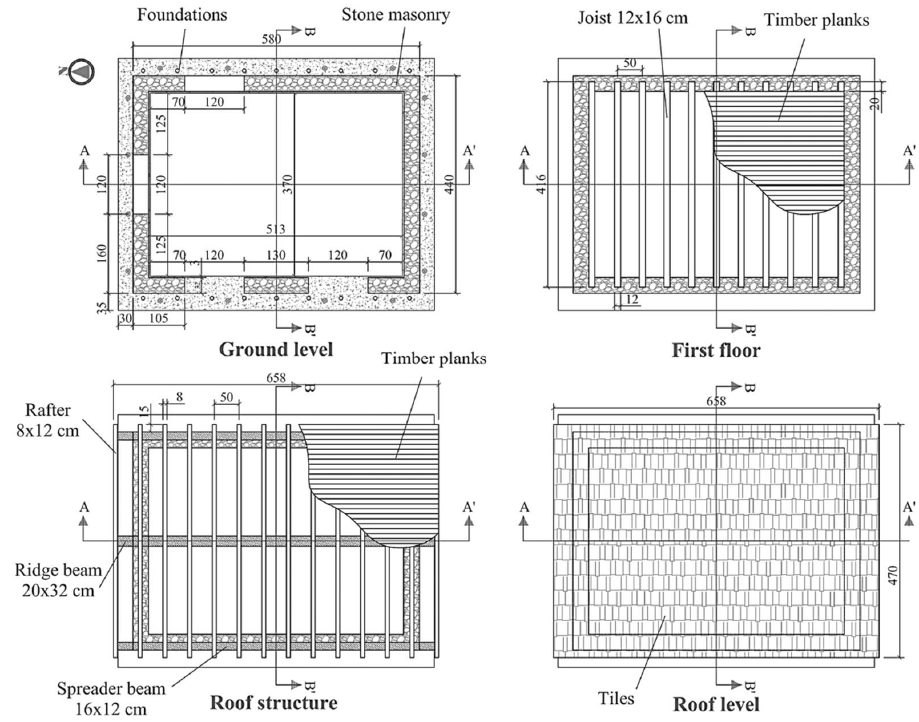
Figure 2. Plan views of the reference building prototype (Building 1). Units of cm.